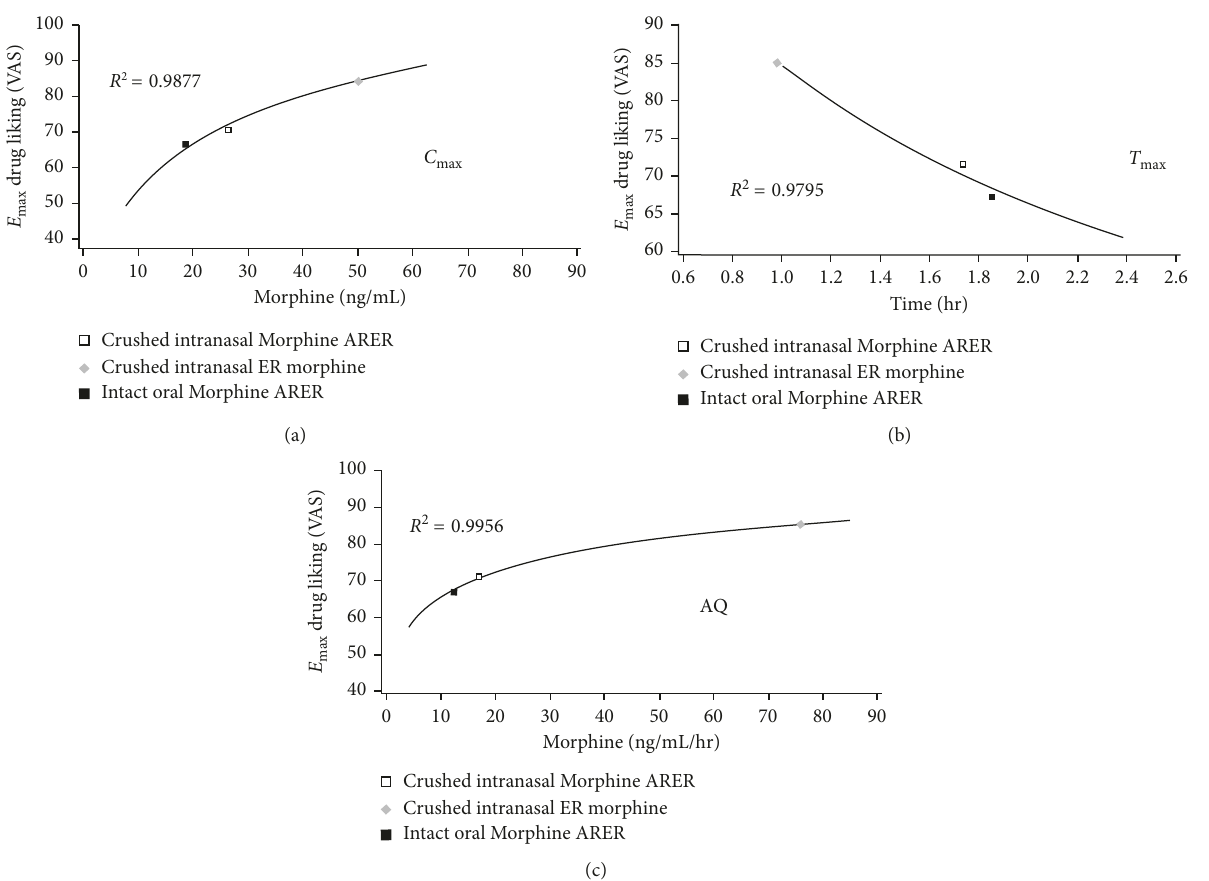
Figure 3: Average time-curve plots of E drug-liking VAS versus AQ (PD population, N maximum effect for drug liking, T max